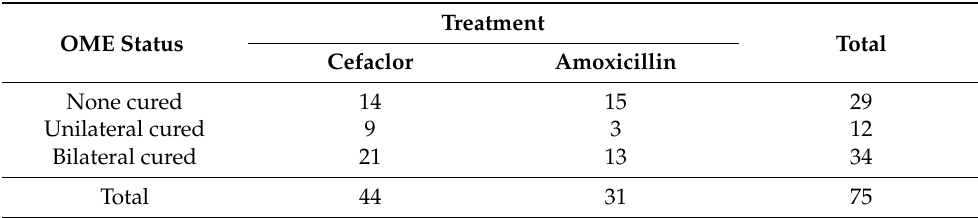
Table 5. OME status after 14-day course of antibiotic